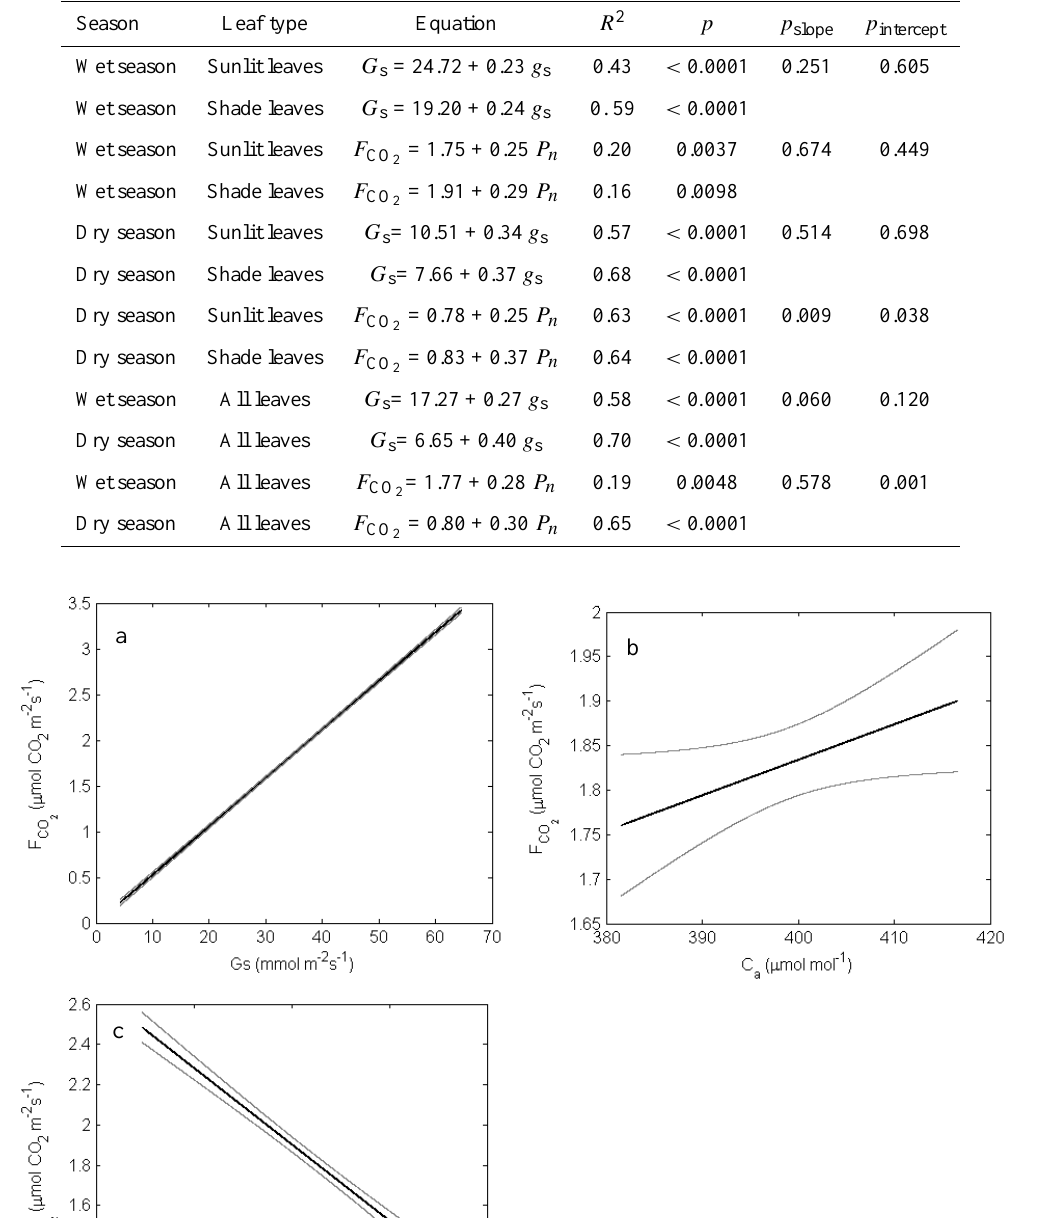
Table 4. The regression lines in Fig. 6 and covariance analysis.